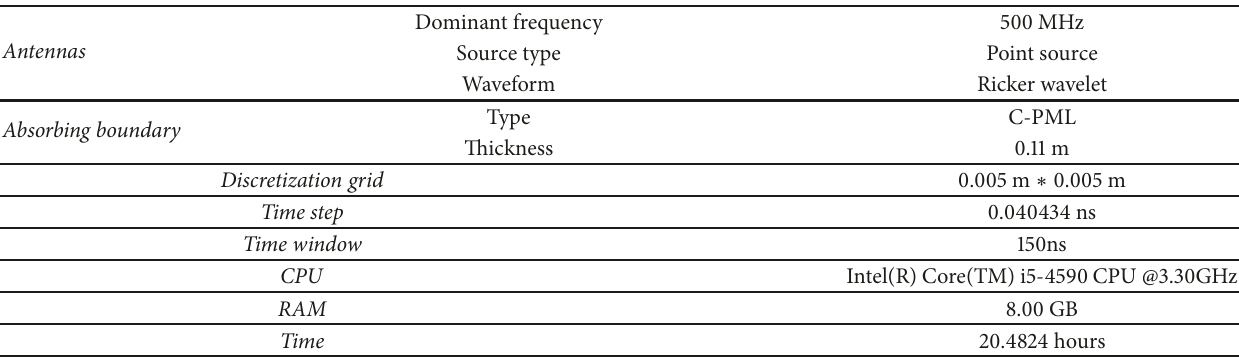
Figure 7: (a) Adaptive f-x EMD result of the integrated model, (b) the map of corresponding removed IMFs number. Table 2: Simulation